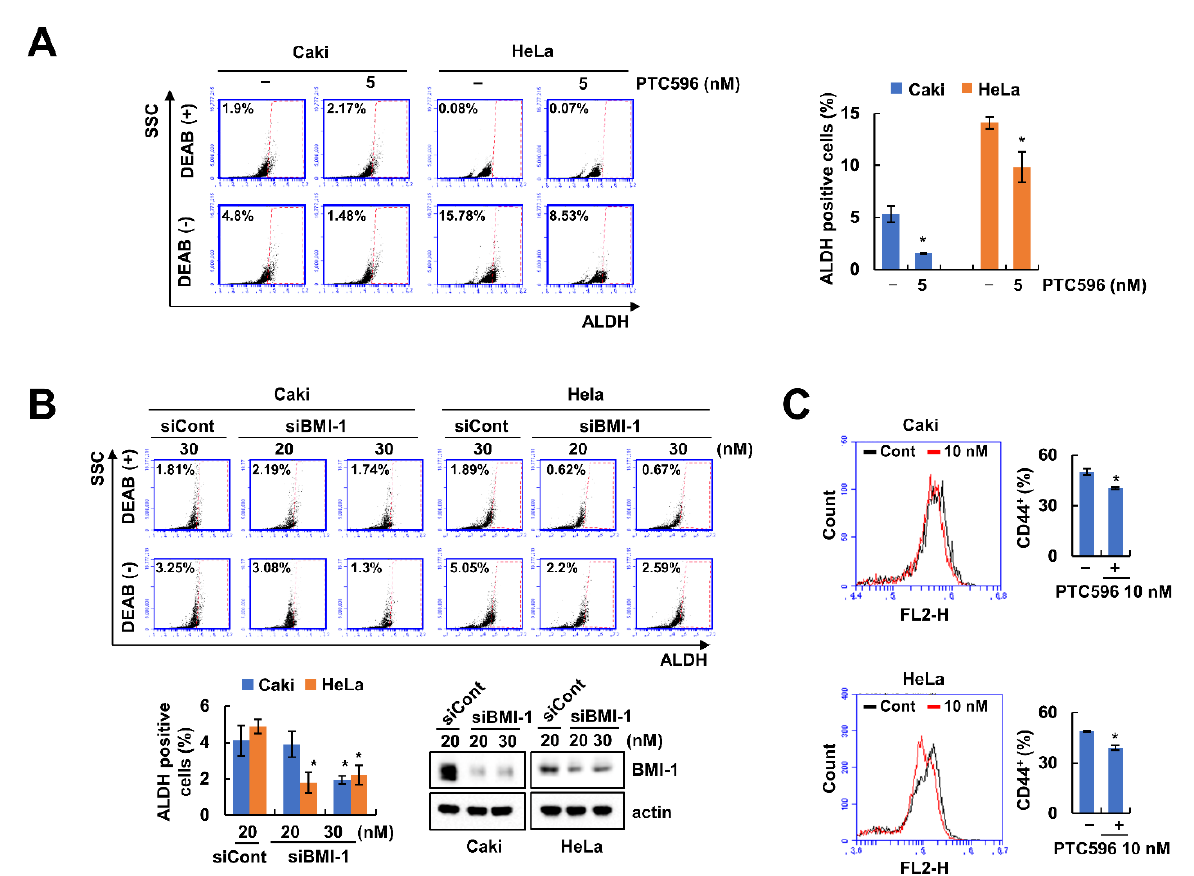
Figure 1. Inhibition of BMI-1 decreases the cancer cell stem-like cell population: ( A ) Caki and HeLa cells were treated with BMI-1 inhibitor PTC596 (5 nM) for 12 h; ( B ) Caki and HeLa cells were transfected with Control (Cont) or BMI-1 siRNA for 24 h. The population of stem-like cells was detected by flow cytometry and the protein expression was quantified by Western blotting ( B ); ( C ): The CD44 cancer stem cell marker was analyzed by flow cytometry in PTC596-treated Caki and HeLa cells. * p < 0.05 compared to the control.